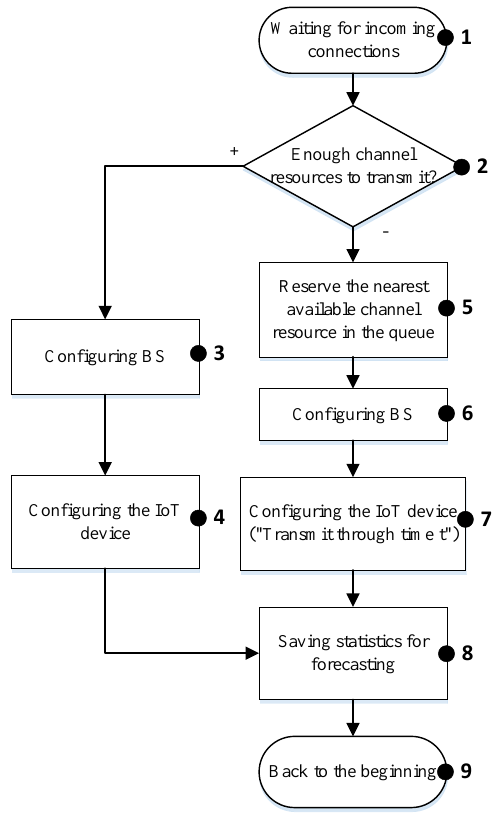
Figure 4. Block- diagram of the algorithm for managing “smart queue” for IoT class L3. Figure 4. Block-diagram of the algorithm for managing “smart queue” for IoT class